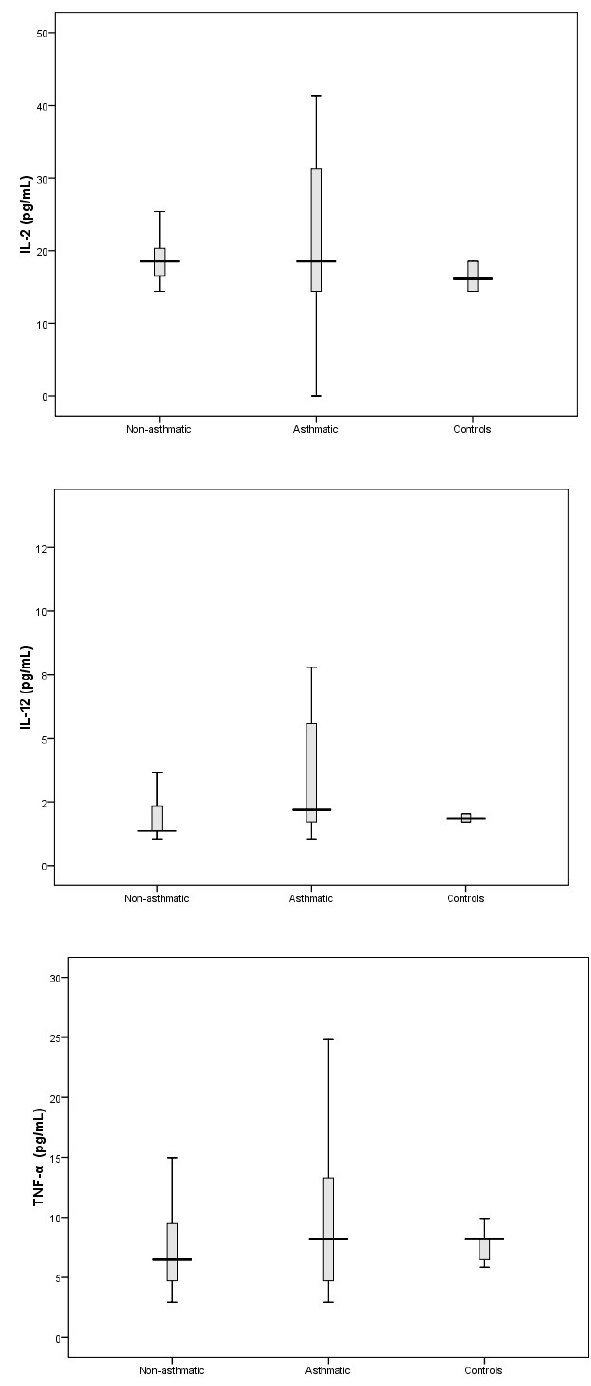
Figure 3. Levels of IL-2, IL-12, and TNF- α in nasal secretions of non-respiratory disease controls, and in RV-C-infected patients with asthma and without asthma. Levels of TNF- α , IL-2, and IL-12 did not significantly differ when each group (asthmatics and non-asthmatics patients) was individually compared to controls.